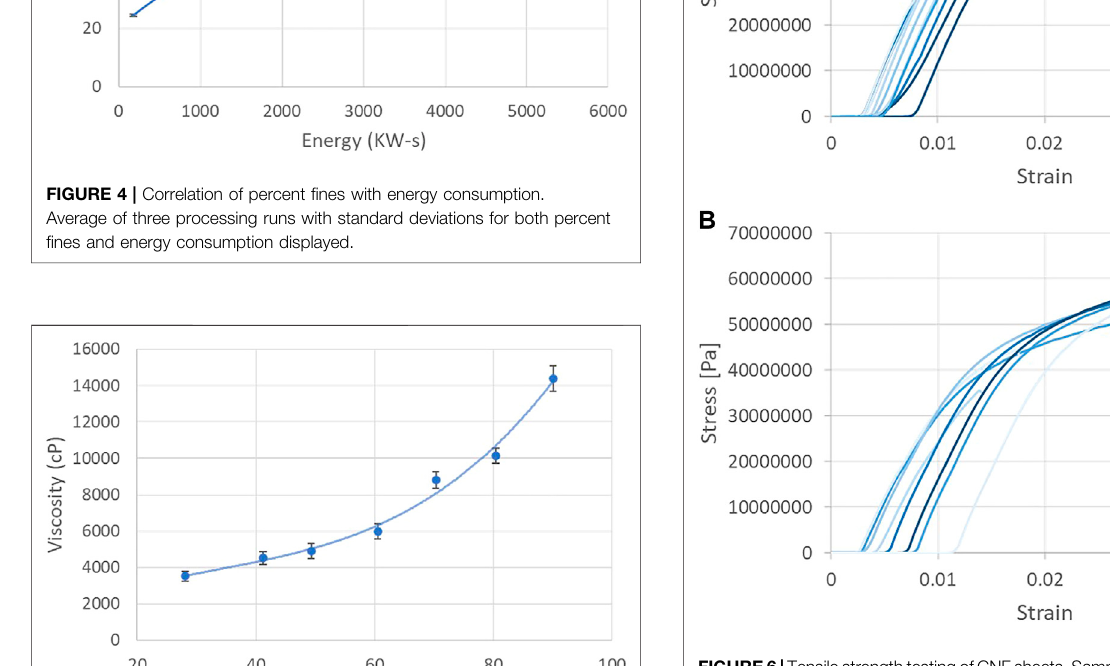
FIGURE6| TensilestrengthtestingofCNFsheets.Samplestakeninthe machine (A) and cross-machine directions (B)